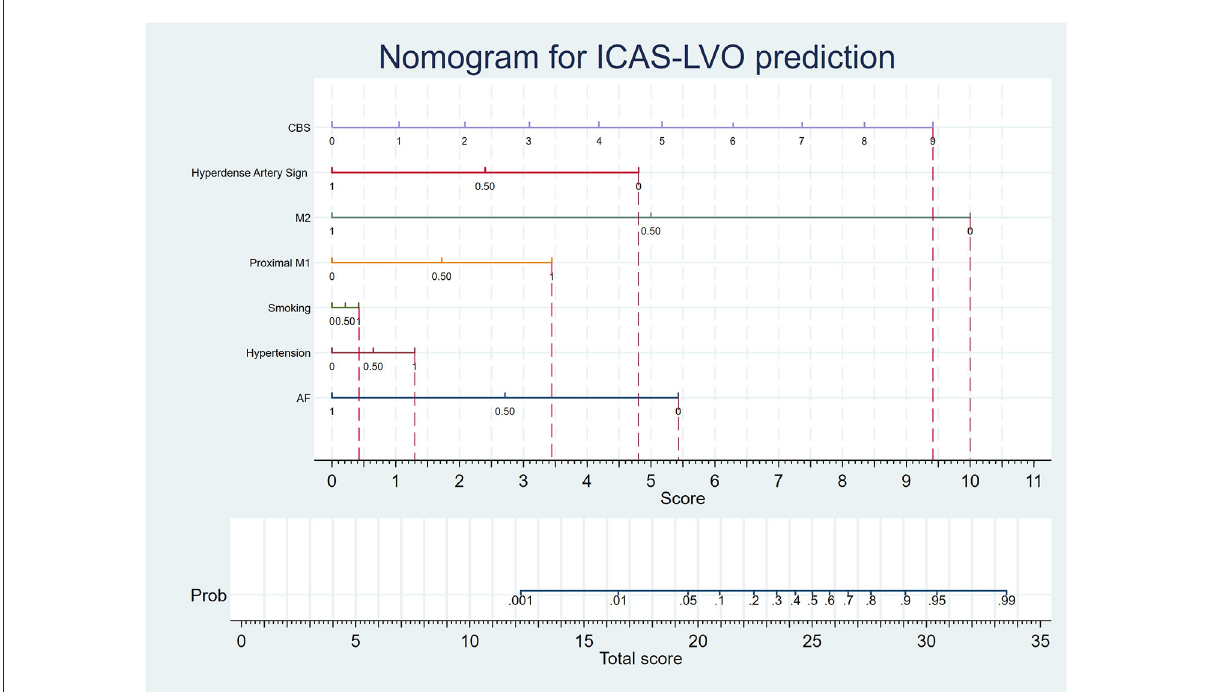
FIGURE2 The nomogram is based on the adjusted prediction model. When predicting the etiology of LVO, the medical histories, imaging data, and CBS of the patient were collected. According to the nomogram, if the patient does not have an AF history, he will gain a 5.4 score. If the patient has a hypertension history, he will gain a 1.3 score. If the patient has a smoking personal history, he will gain a 0.4 score. If the patient has occlusion at the proximal M1 segment, he will gain a 3.4 score. If the patient does not have occlusion at the M2 segment, he will gain a 10 score. If the patient does not have a hypertense artery sign, he will gain a 4.8 score. The patient will gain 0, 1.1, 2.1, 3.1, 4.2, 5.2, 6.3, 7.3, 8.3, and 9.4 scores, if his CBS were 0, 1, 2, 3, 4, 5, 6, 7, 8, and 9 respectively. Afterward, the physician can calculate the total score of the patient, and the probability